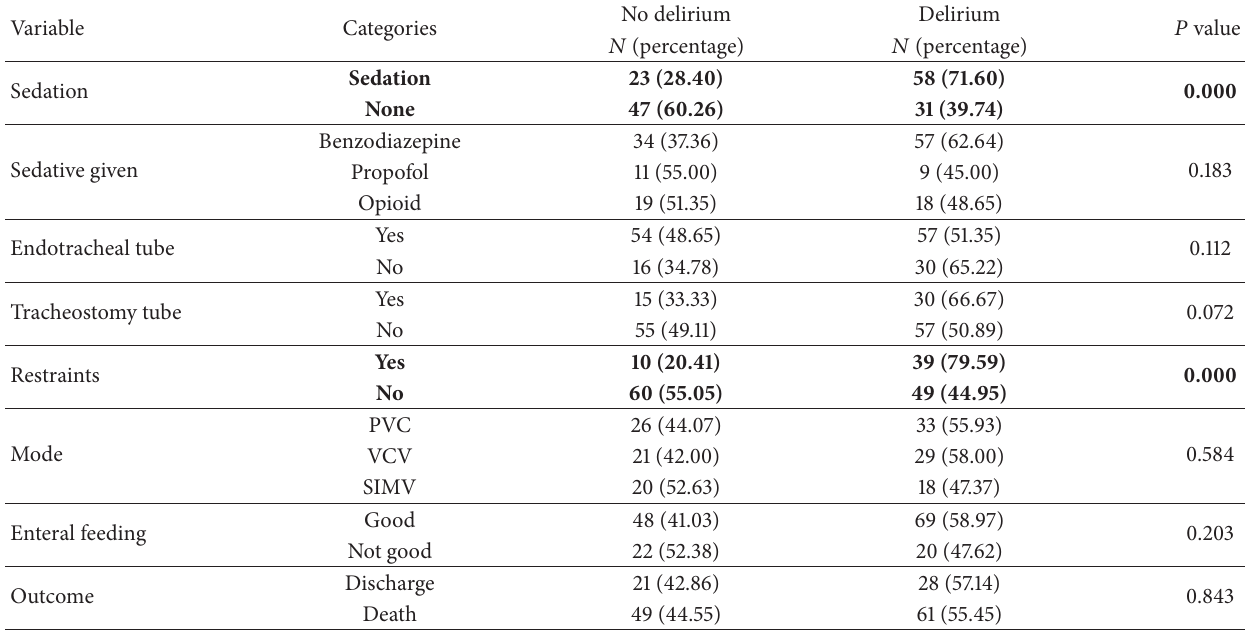
Table 3: ICU treatment characteristics.